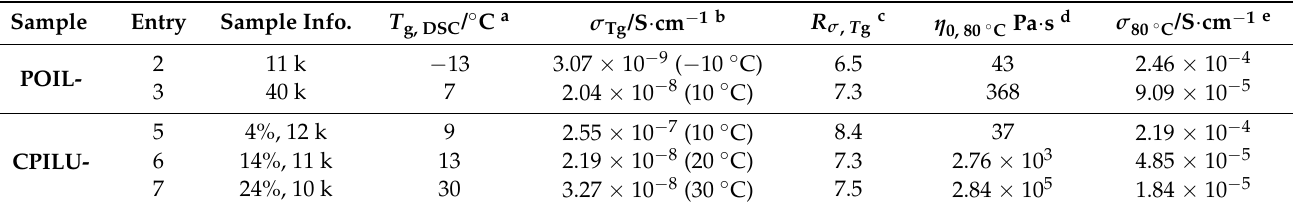
Table 4. Glass transition temperature and conductivity at glass transition temperature, and zero shear viscosity and conductivity at 80 ◦ C of POIL-x and CPILU-y